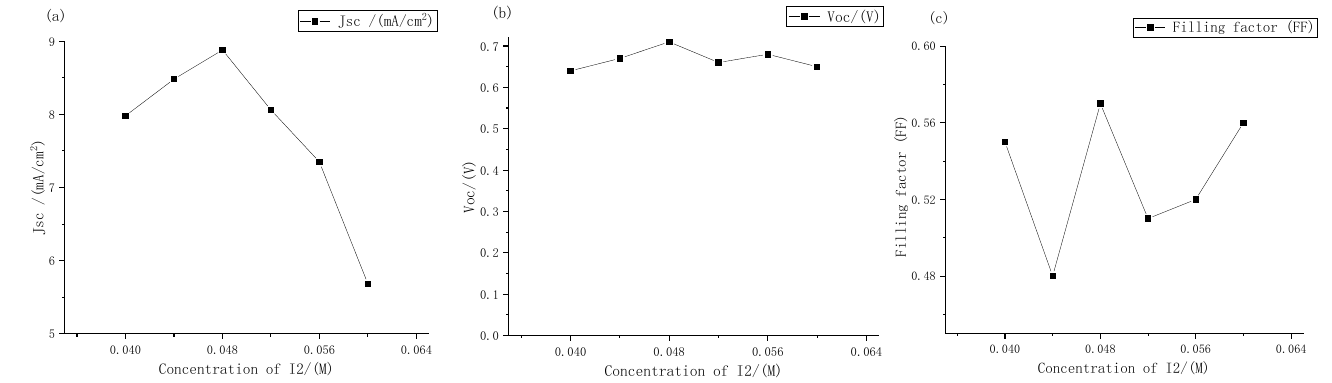
Figure 10. Performance changes of the external photoanode structure DSSC with different concen- tration of iodine under large gradient: ( a ) short circuit current density; ( b ) open circuit voltages; ( c ) filling factor.